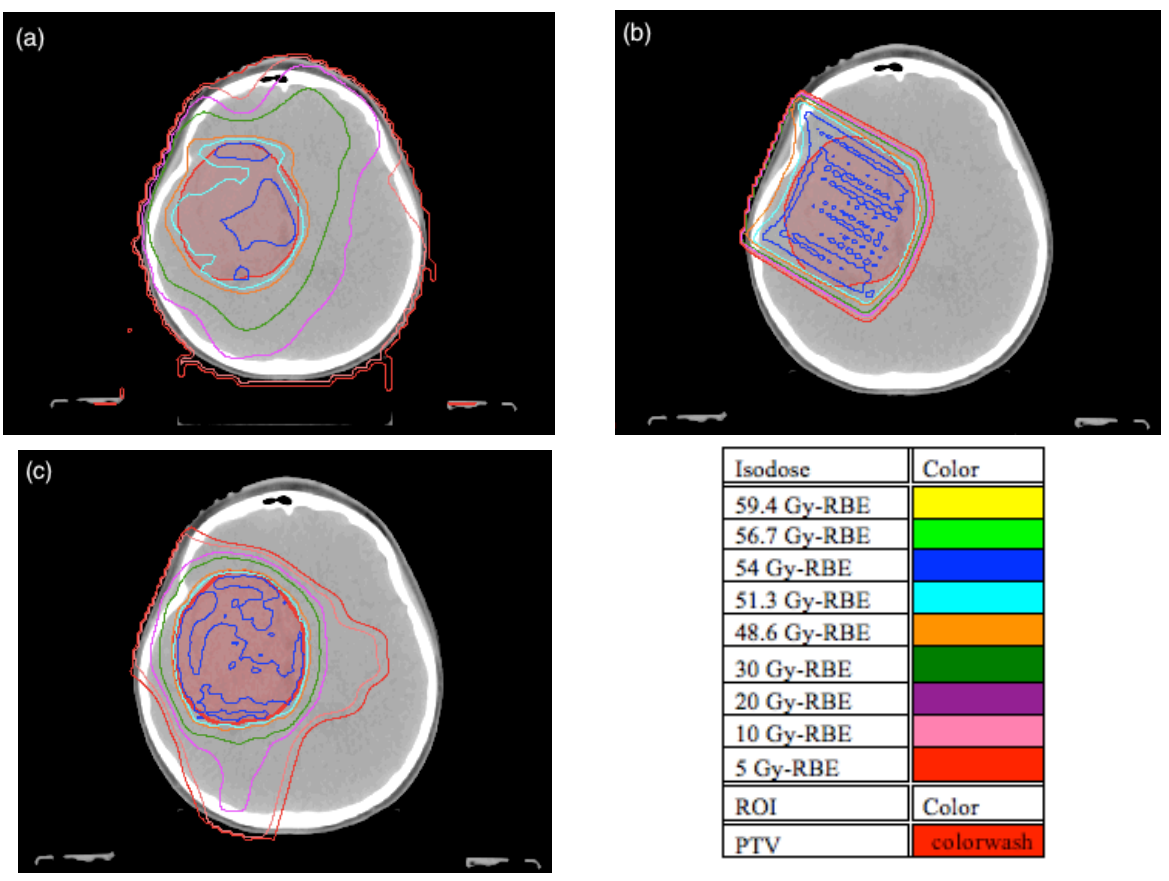
Figure 2. Patient 5 isodose distribution at isocenter CT slice location for ( a ) volumetric modulated arc therapy (VMAT), ( b ) passively scattered proton therapy (PSPT), and ( c ) intensity modulated proton therapy